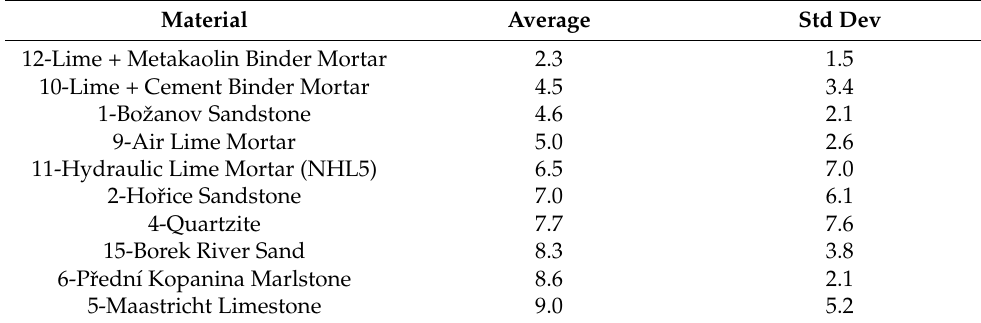
Table 1. Sample D—average material ranking in processed